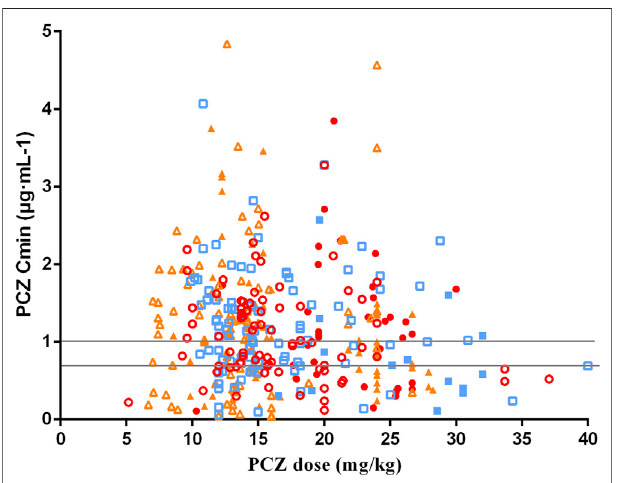
FIGURE2| DistributionforPCZCminatdifferentweight-adjusteddoses received. Solid and hollow red circles represent the data obtained of PCZ prophylaxis and treatment in children aged < 6 years old, respectively. Solid and hollow blue square represent the data obtained of prophylaxis and treatment in children aged 6 – 12 years old, respectively. Solid and hollow orange triangles represent the data obtained of prophylaxis and treatment in children aged > 12 years old, respectively. Two horizontal lines indicates the therapeutic range of PCZ prophylaxis and treatment (0.7 μ g · mL-1 and 1.0 μ g · mL-1).